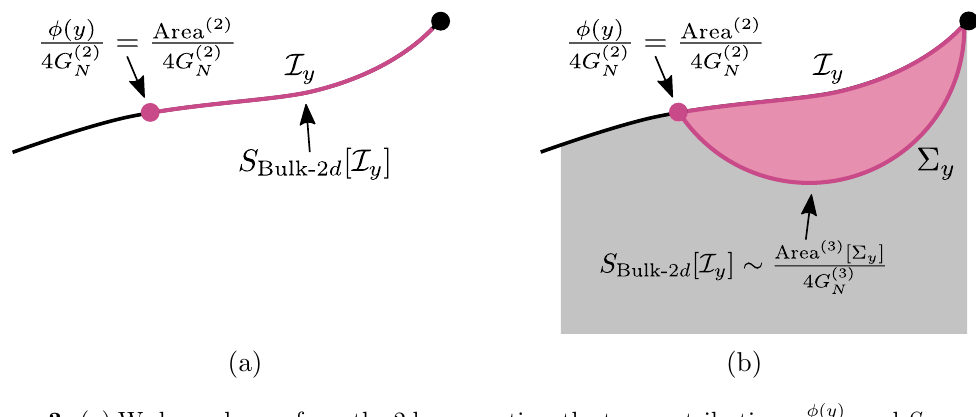
and S Bulk-2d [ I y ] 4 G (2) N